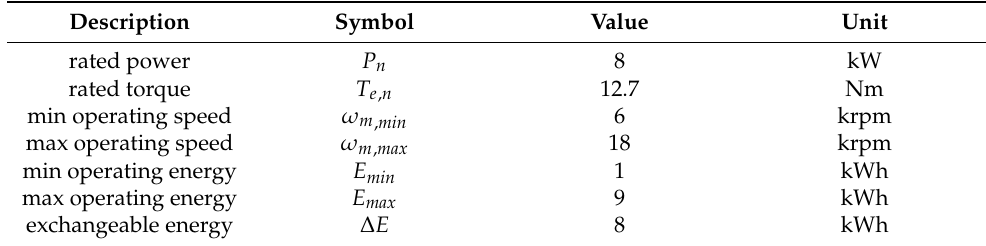
Figure 9. Daily load magnitude ( a ) and PV production profile ( b ) of the domestic user considered for simulations (pu values, P base = 8 kW). Table 2. Main specifications of the proposed FESS.